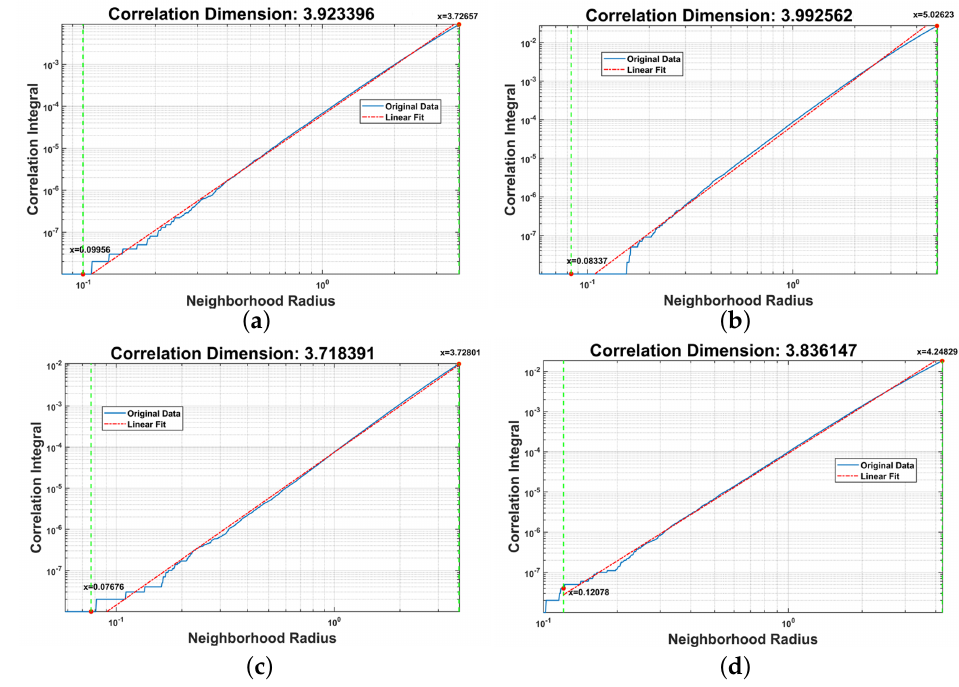
Figure 11. CD for several signals from the RC dataset. ( a ) CD for a signal from the class P1, ( b ) CD for a signal from the class P6, ( c ) CD for a signal from the class P11, ( d ) CD for a signal from the class